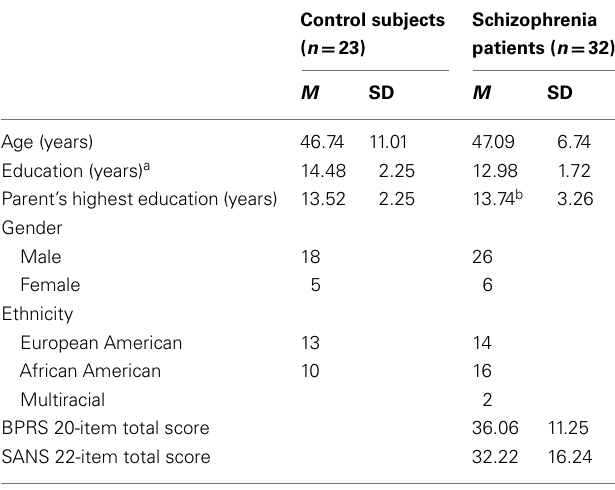
Table 1 | Demographic and symptom rating data for control subjects and schizophrenia